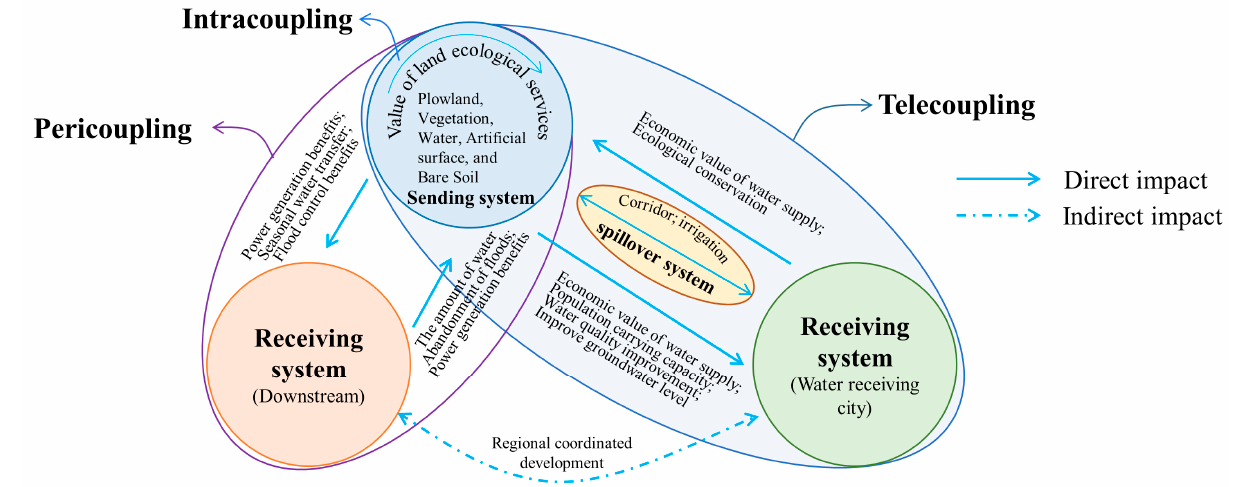
Figure 7. Schematic diagram of SNWTP-MR metacoupling ecological value.